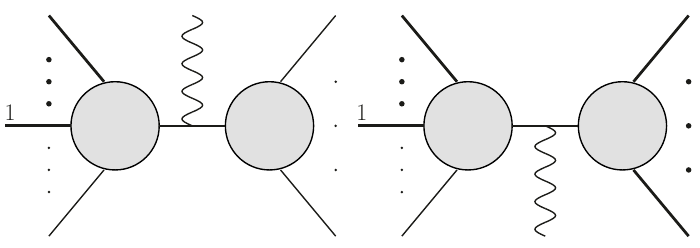
Figure 11 . Two allowed configurations. The leg 1 is at left, and the orderings in diagrams are